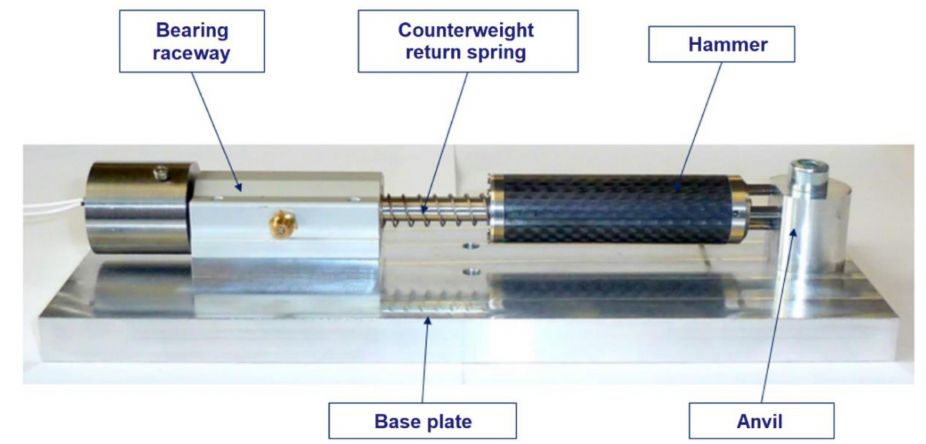
Figure 12. Laboratory model of the